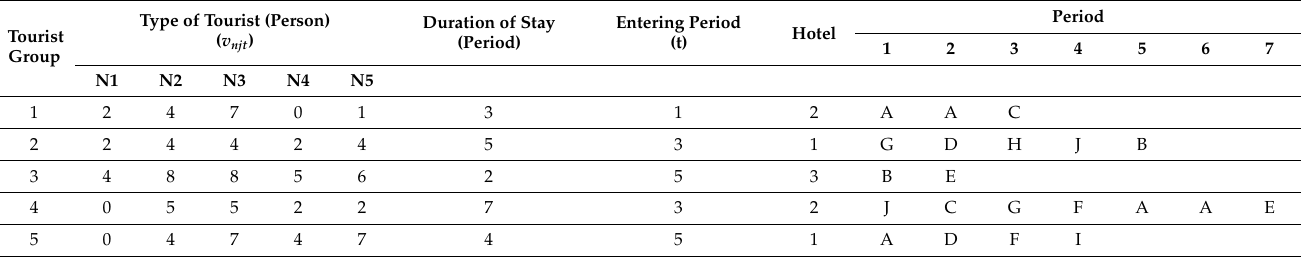
Table 2. Decoding result of Example